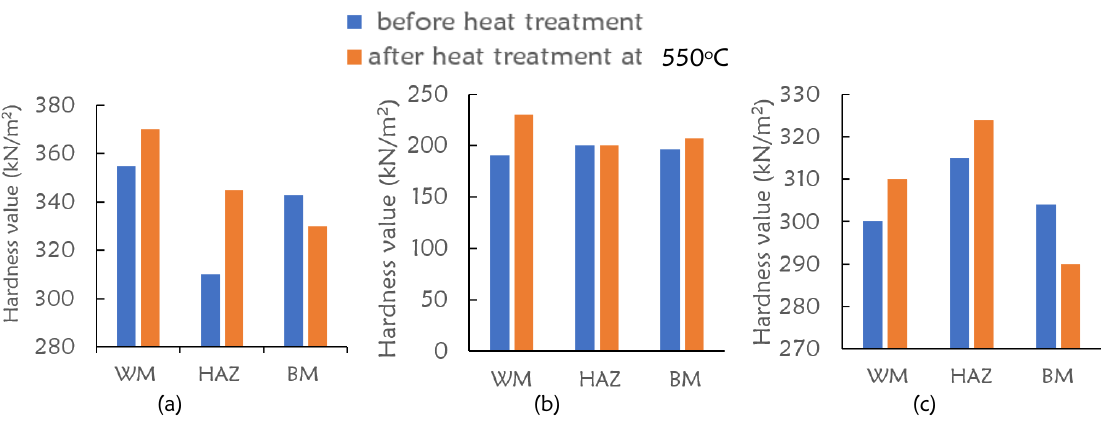
Figure 6: Plot of Hardness values of welded joints in different zones under the same working conditions for (a) high carbon steel, (b) medium carbon steel, and (c) low carbon